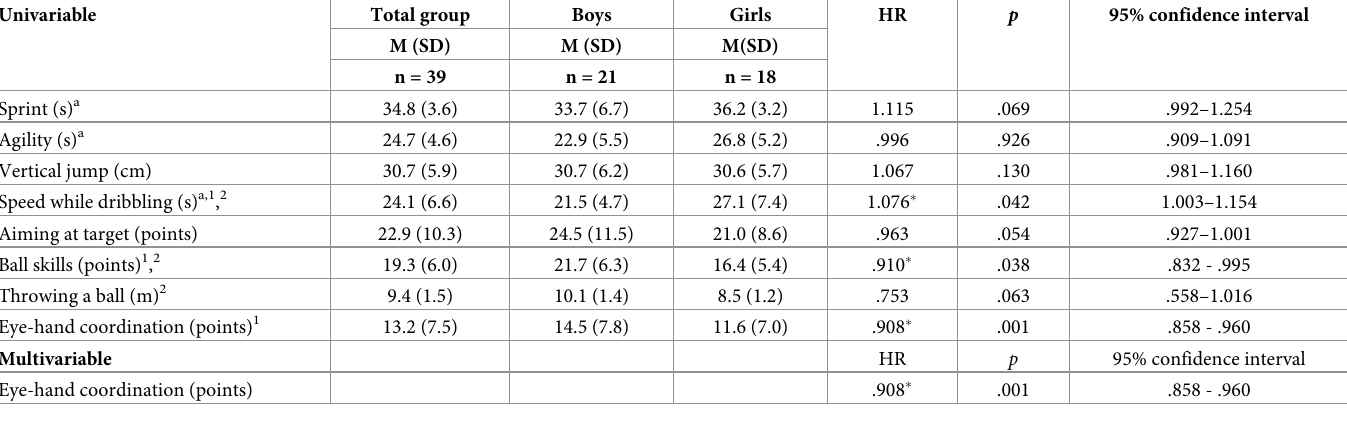
Table 1. Descriptive statistics and Cox regression analysis of dropout rates examining the perceptuo-motor skills